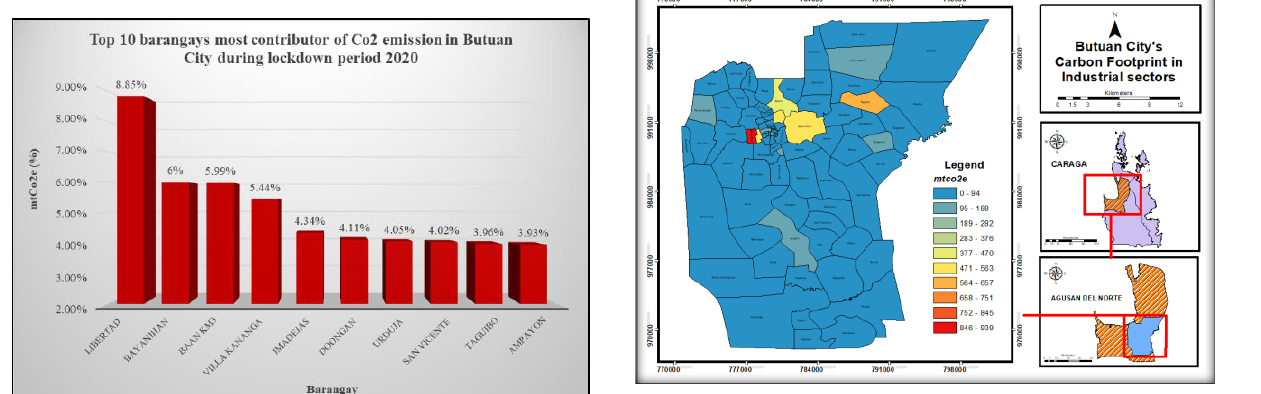
Figure 10. Spatial distribution of carbon footprint from Industrial electricity consumption during COVID-19 lockdown (a month of April & May-2020) in Butuan City.